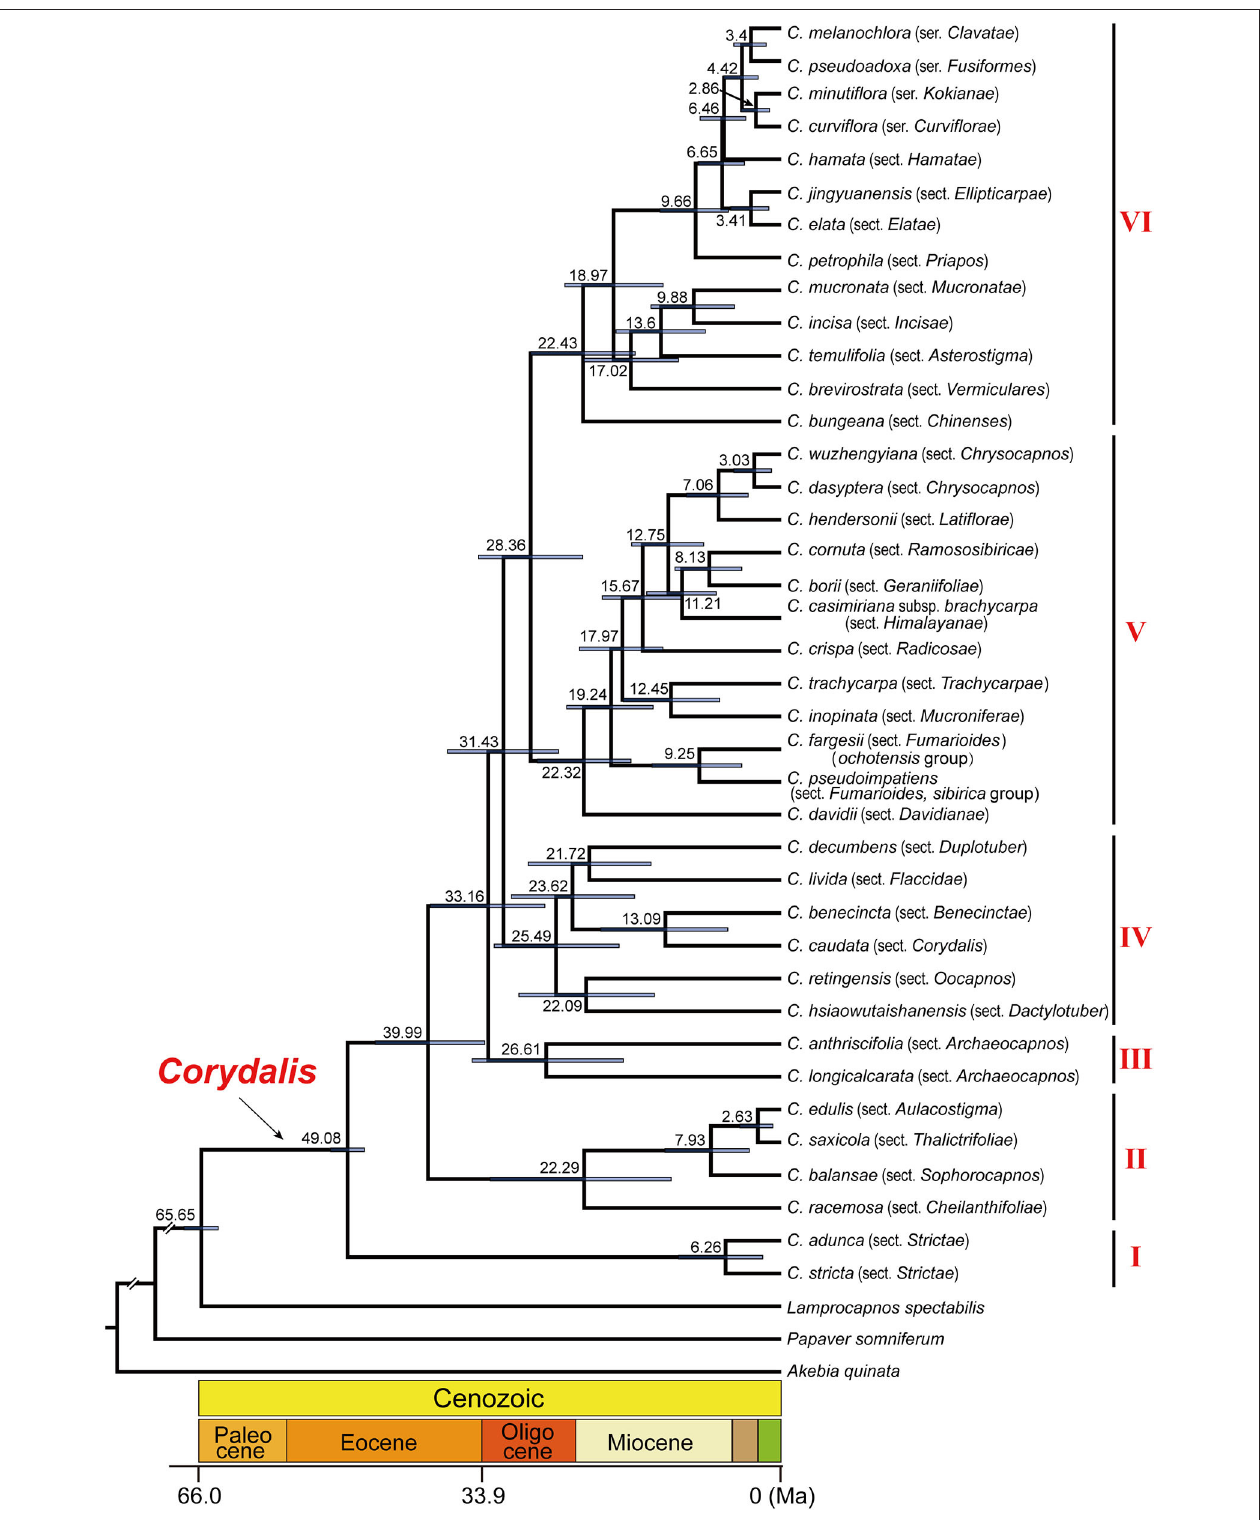
FIGURE 4 | Detailed chronogram showing divergence time of Corydalis estimated in BEAST based on all the 39 Corydalis plastomes. Estimated mean ages are shown near the nodes, and blue bars represent 95% high posterior density.